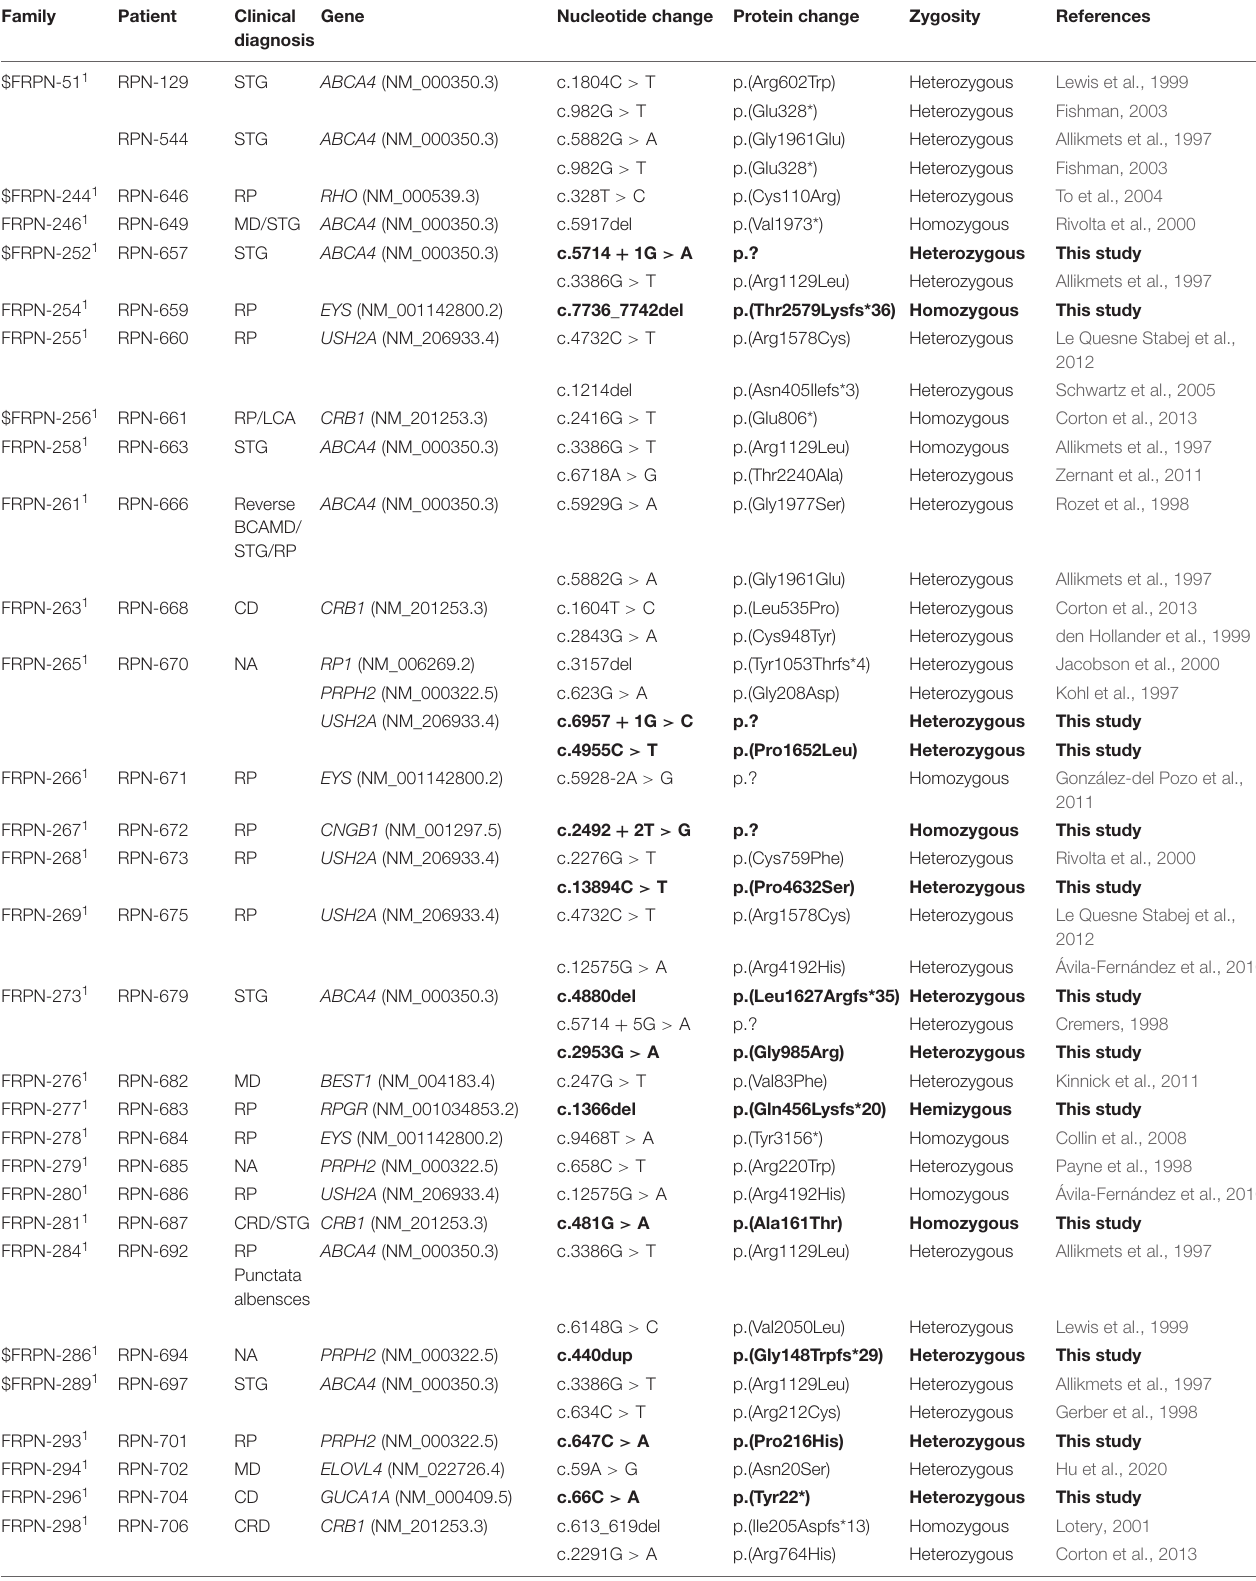
TABLE 1 | Pathogenic variants identified in solved